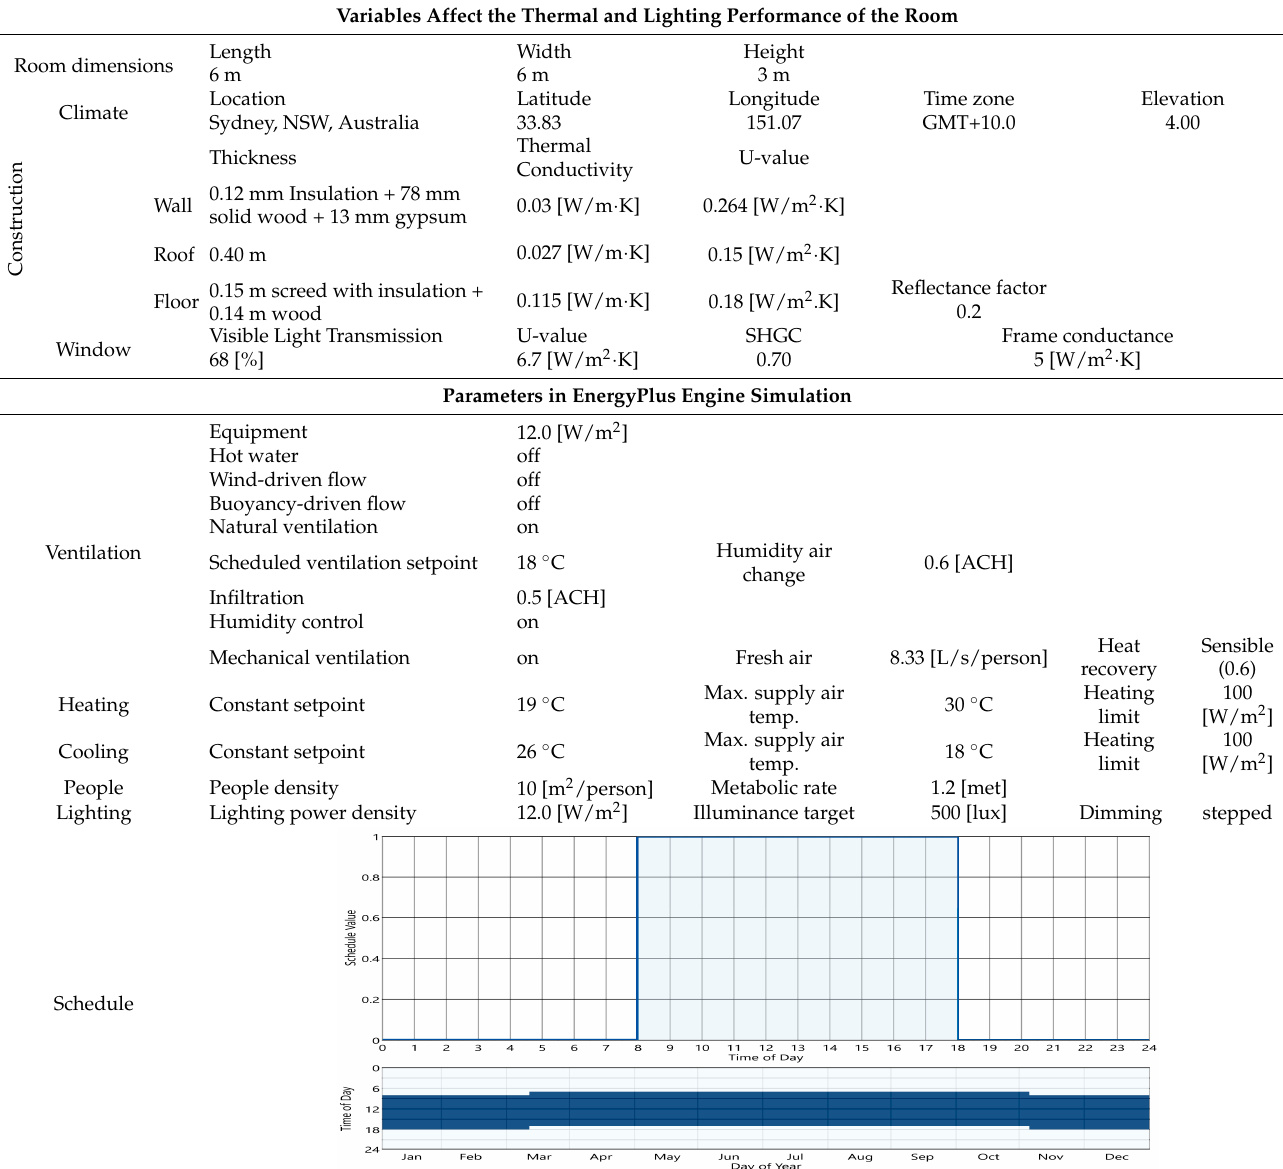
Table 1. The parameters applied in the